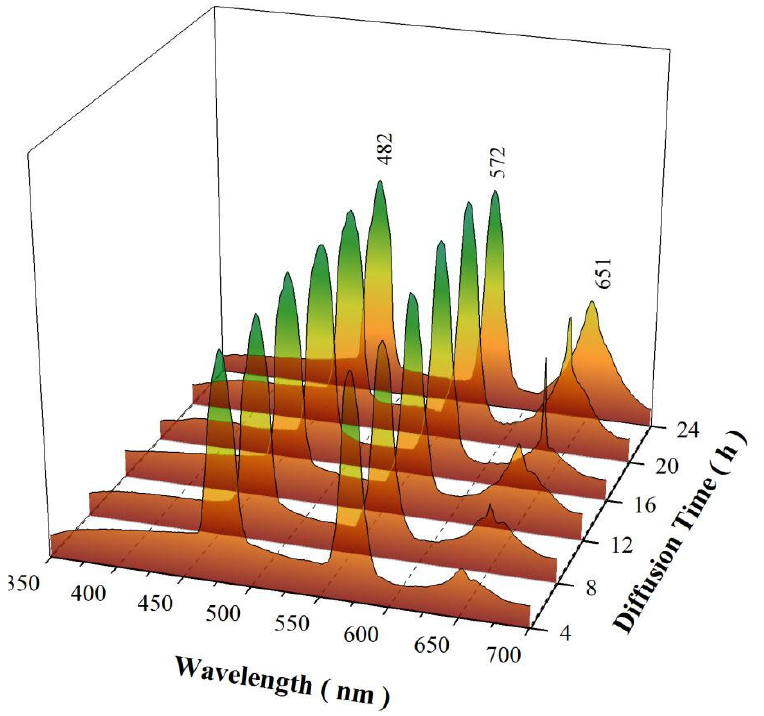
Figure 7. PL spectra of SrAl 2 O 4 :Dy 3+ (1.6 mol%) after Mn 4+ diffusion at 800 °C for different times: 4 h, 8 h, 12 h, 16 h, 20 h, and 24